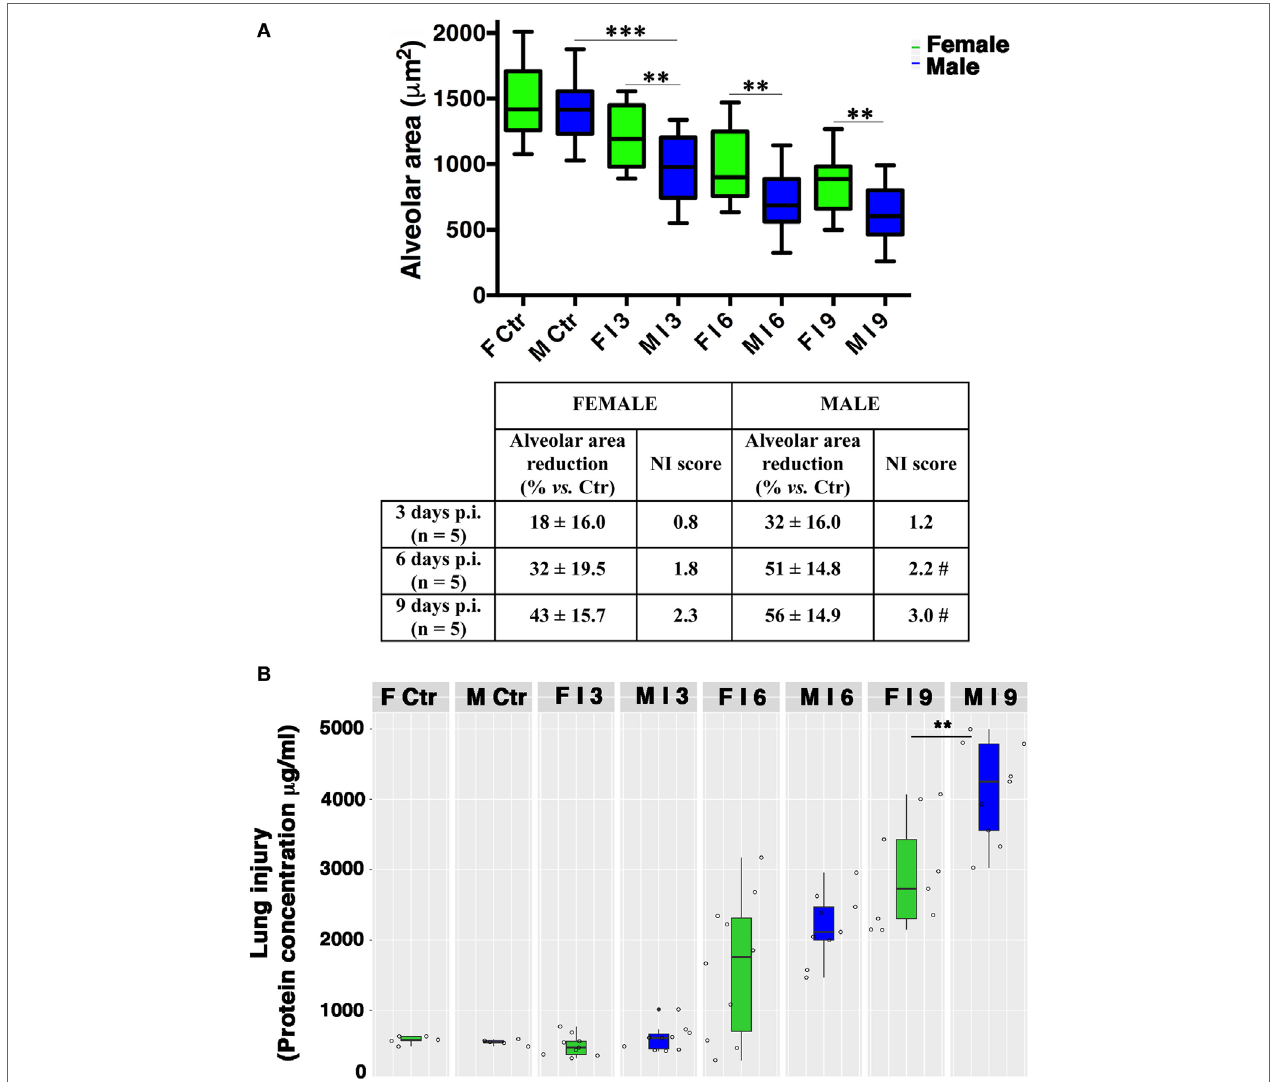
FigUre 3 | Male mice display reduced alveolar area compared with females. (a) Morphometric analysis at different days post-infection in female (F) and male (M) mice infected as described in Figure 2 . The graph shows box-plots of alveolar area ( μ m 2 ) of PR8-infected (I) and mock-infected mice (Ctr). ** p -Value < 0.01 females vs. males (unpaired t -test); *** p -value < 0.001 Infected vs. Ctr (One-way ANOVA Bonferroni multiple comparisons test). On table below the graph, the percentage of reduction of free to air exchange vs. mock-infected (considered 100%), and the score of inflammation and necrosis (NI score) are shown. # Relevant reduction of the alveolar area, thickening of the alveolar septa, vascular congestion. (B) Box-plots of protein concentrations in the BALF from mock-infected (Ctr) and PR8-infected female and male mice at the time points indicated. Results represent data pooled from three separate experiments. In details, mock-infected mice were 10 (5/sex), infected mice on p.i. day 3 were 19 (9 females and 10 males), on p.i. day 6 were 19 (10 females and 9 males), on p.i. day 9 were 18 (9/sex), ** p -value =